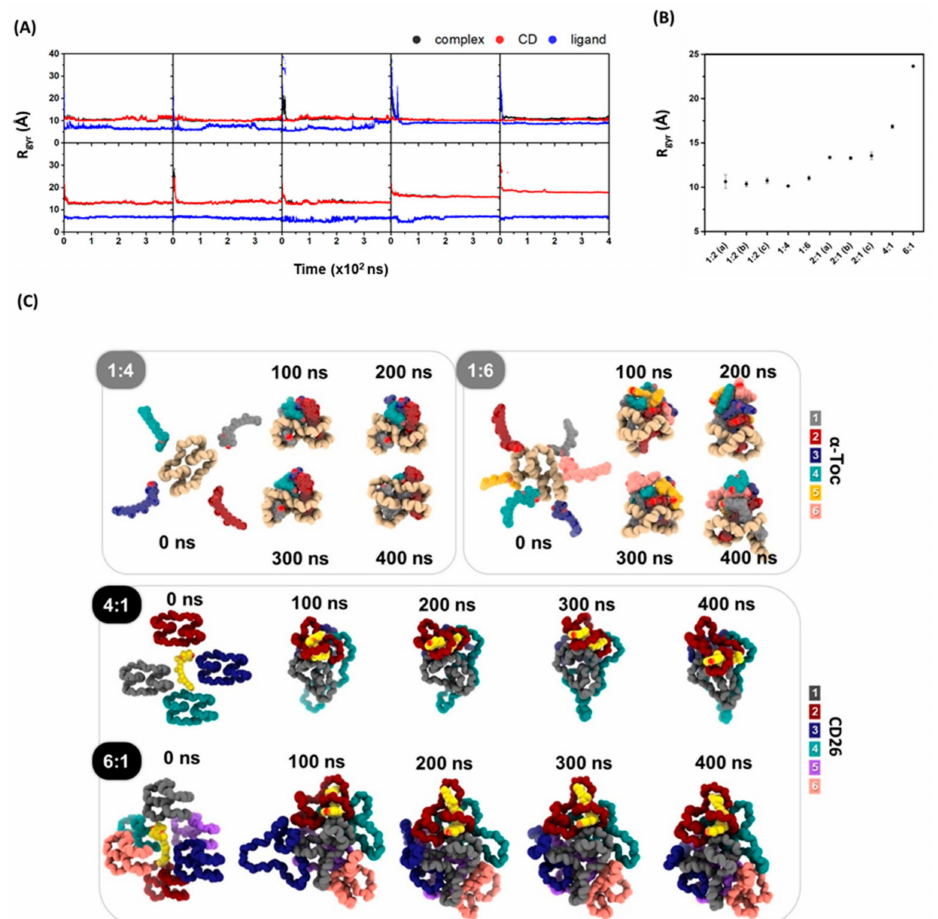
Figure 4. ( A ) The R g of all the CD26/ α -tocopherol systems versus the MD simulation time. ( B ) The R g values of the complex atoms averaged over the last 100 ns of the simulations. ( C ) MD snapshots at different time points for the 1:4, 1:6, 4:1, and 6:1